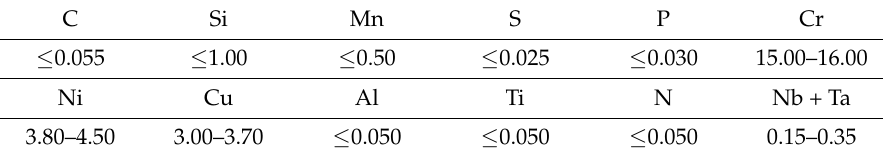
Table 1. 0Cr17Ni4Cu4Nb internal control chemical composition (wt